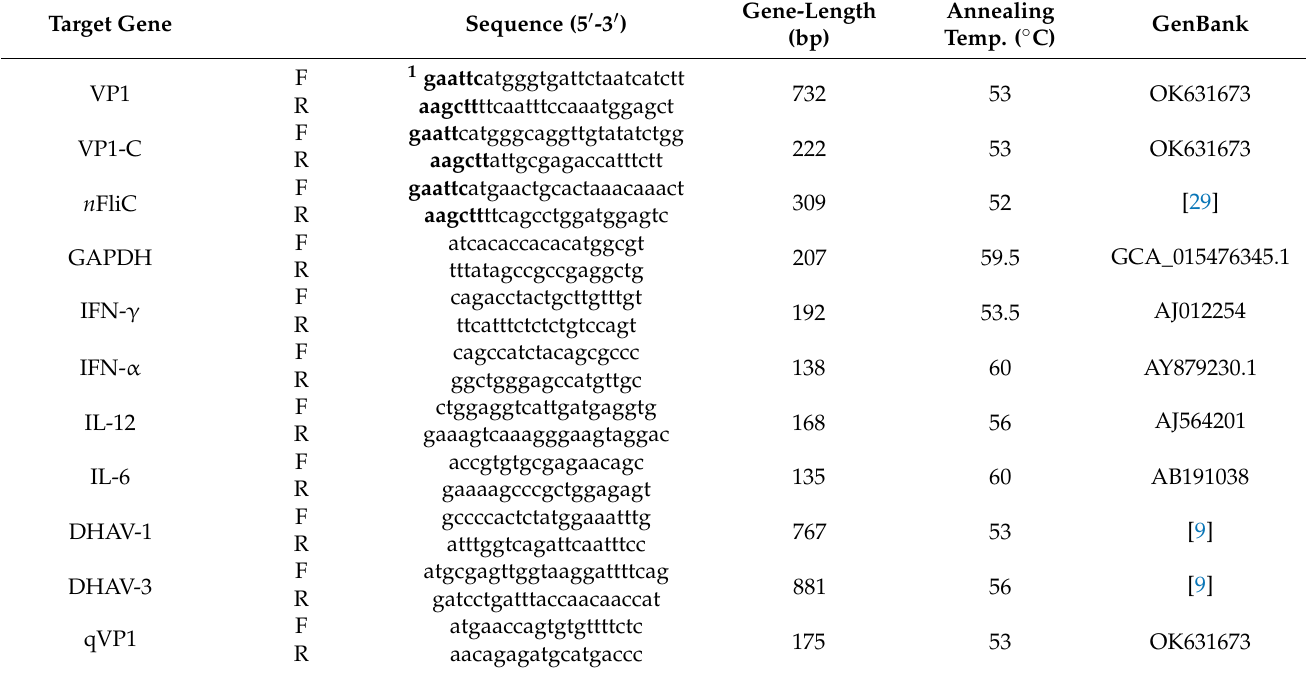
Table 1. Primers for gene cloning and cytokine